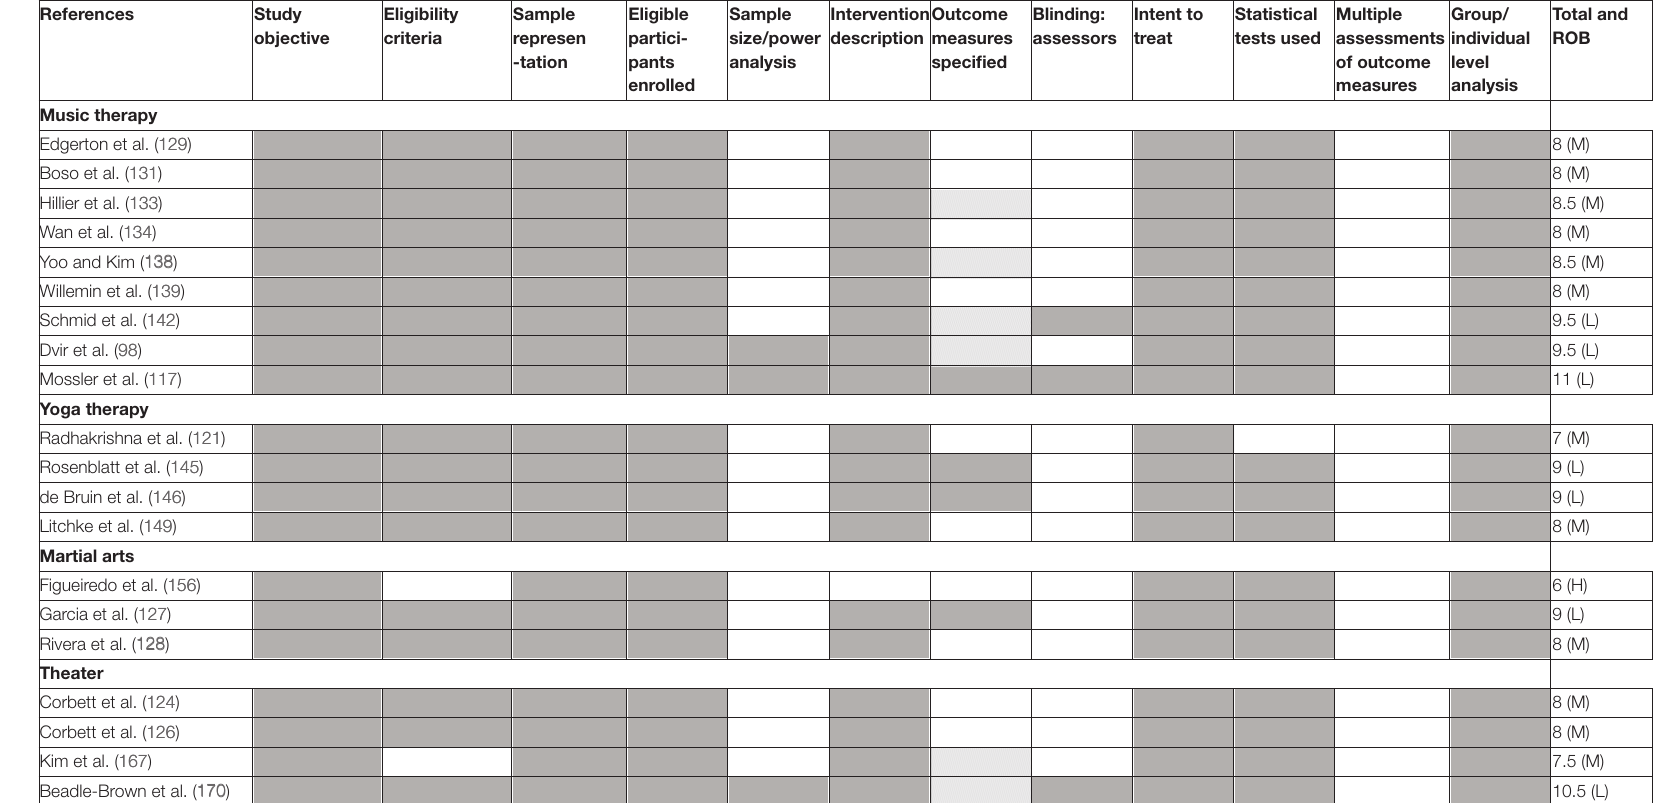
TABLE 2B | NIH quality assessment tool for before-after (pre-post) study design.